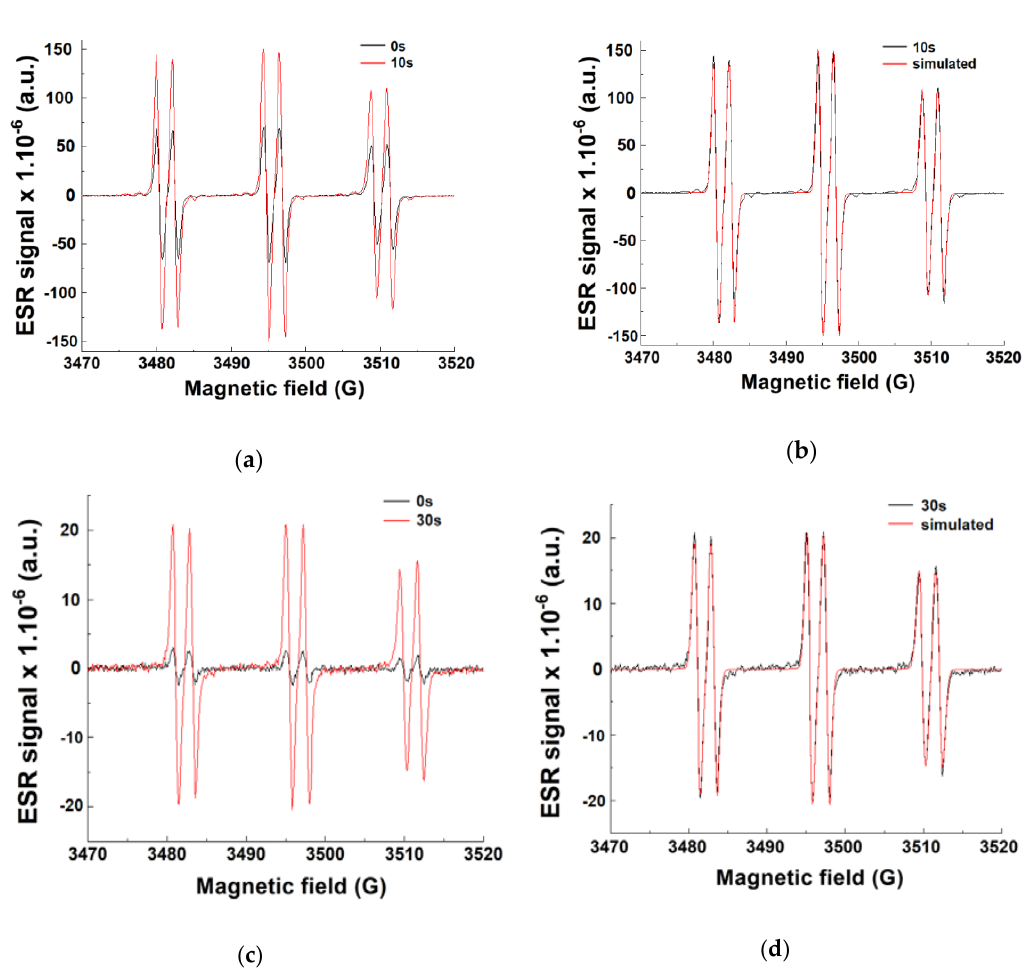
Figure 10. Electron spin resonance (ESR) spectra obtained from ESR-spin trapping experiment using PBN = 2 mg / mL (as spin trap agent); iodonium salt (Iod) or amine (EDB) = 12.6 mg / mL and dye 5 = 0.8 mg / mL in tert -butylbenzene under N 2. : ( a ) dye 5 / Iod, irradiation time = 0 s (black) and = 10 s (red) spectra; ( b ) dye 5 / Iod, irradiation time = 10 s (black) and simulated (red) spectra; ( c ) dye 5 / amine, irradiation time = 0 s (black) and = 30 s (red) spectra; ( d ) dye 5 / amine, irradiation time = 30 s (black) and simulated (red) spectra.